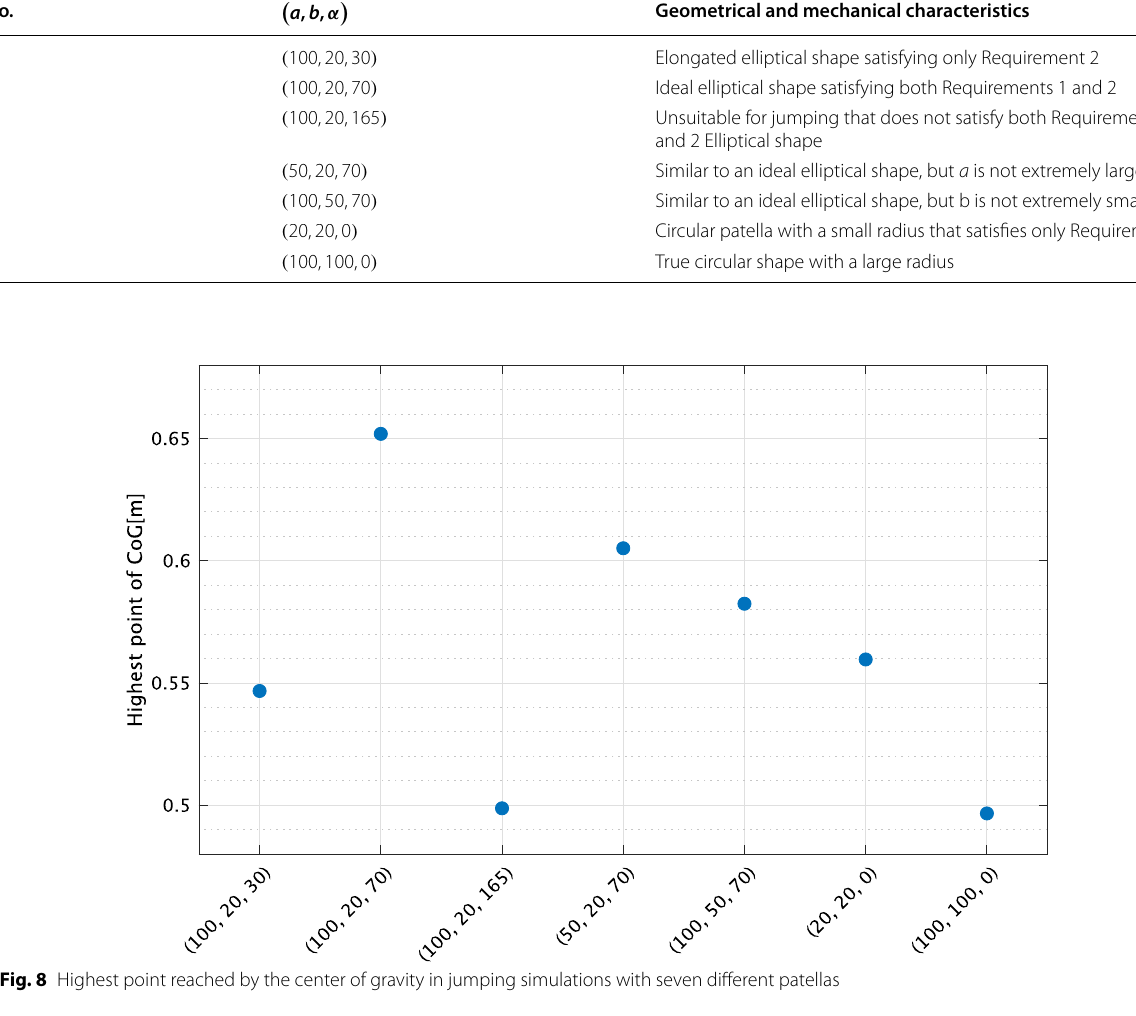
Table 3 Seven compared patella shapes and their mechanical and geometric characteristics No.